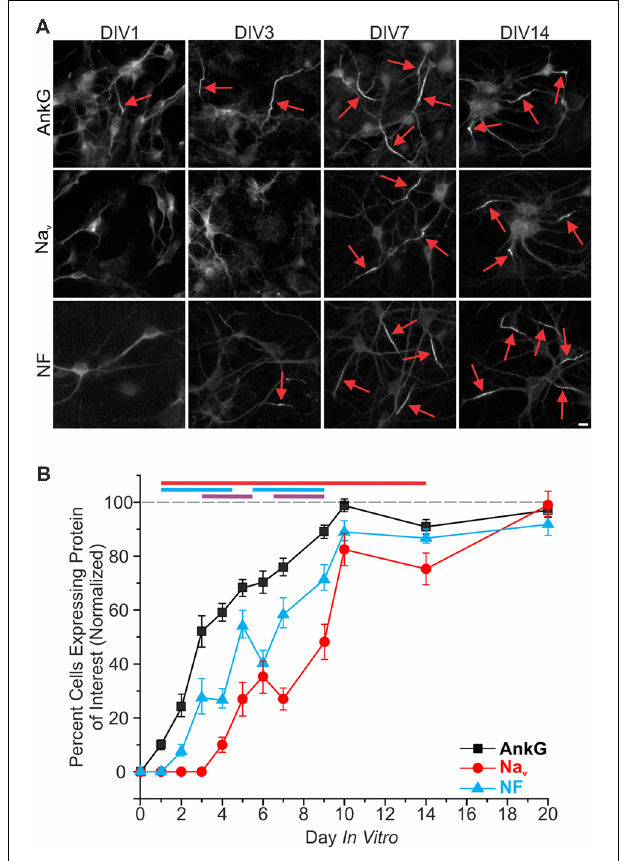
FIGURE 1 | Development of the axon initial segment (AIS). (A) Representative images of immunostaining for ankyrinG (AnkG), panNa v , and neurofascin (NF) at days in vitro (DIV)1, 3, 7, and 14. Red arrows indicate AIS enrichment. Scale bar: 10 µ m. (B) Percentages of neurons containing discernable enrichment at the AIS compared to the soma for AnkG (black), Na v (red), and NF (cyan) during development ( ≥ 10 images/fields of view were quantified for all proteins in all DIV). Error bars indicate mean ± standard error of the mean (SEM). Cyan line at top indicates statistical significance between NF and AnkG, red line indicates statistical significance between Na v and AnkG, and purple line indicates that Na v is statistically significant from NF. All significance indicates p < 0.05, ANOVA with Tukey’s post hoc